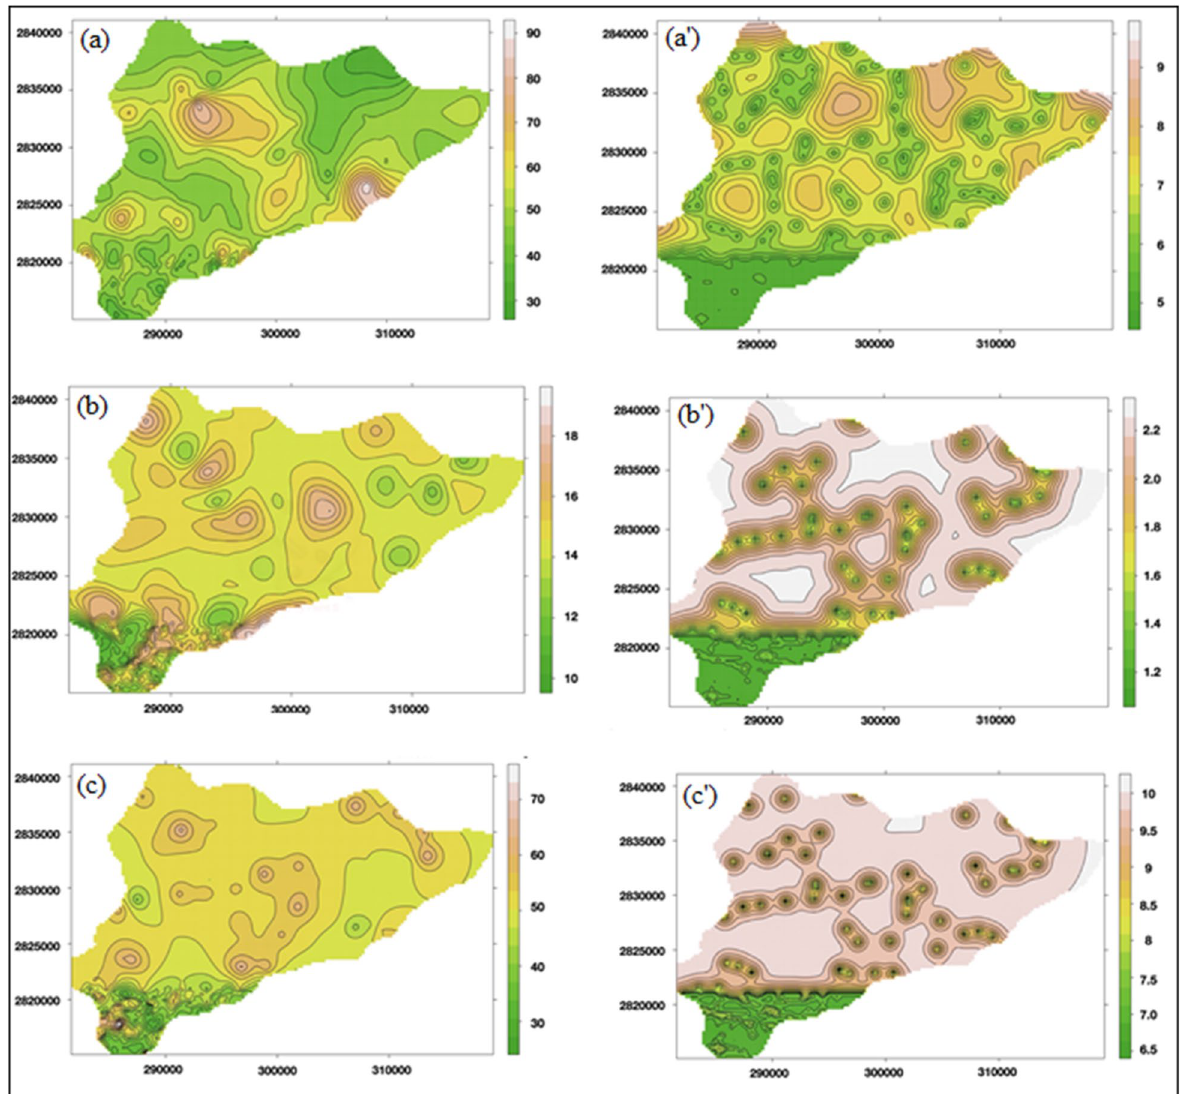
Figure 4. Predicated R-values of ( a ) shallow aquifer (R1), ( b ) intermediate clay layer (R2), and ( c ) deeper aquifer (R3) in Ohm-m corresponding of the predicted R-values as ( a ′ ) R1, ( b ′ ) R2, and ( c ′ ) R3 (in Ohm-m), respectively (J.D.: sketched this figure with the help of R Core Team (2013). R: A language and environment for statistical computing. R Foundation for Statistical Computing, Vienna, Austria, http:// www.R- proje ct.